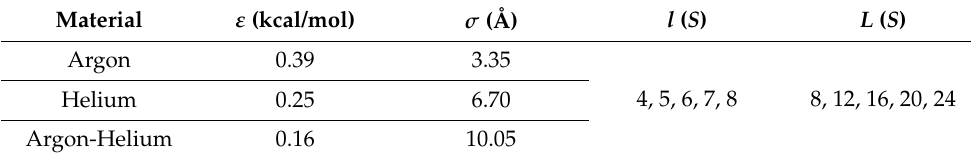
Figure 1. The setup of the simulation system. Table 1. The parameters used in the simulation.